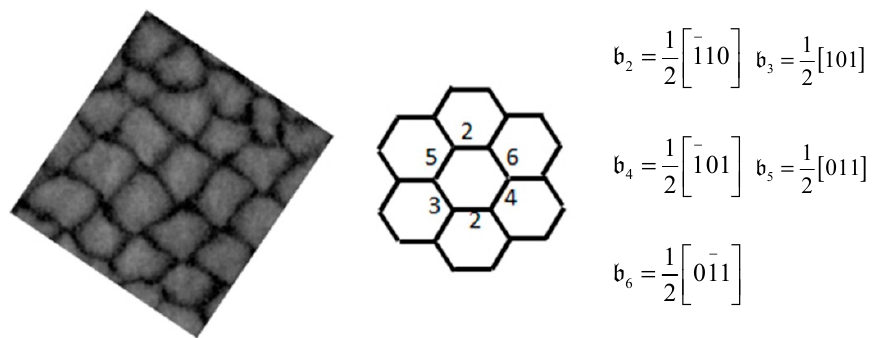
Figure 4. Part of the dislocation network of a (110)/(110) bond wafer pair shown in Figure 3 and schematic representation of the dislocation structure. The numbers specify the corresponding Burgers vectors listed on the right side.